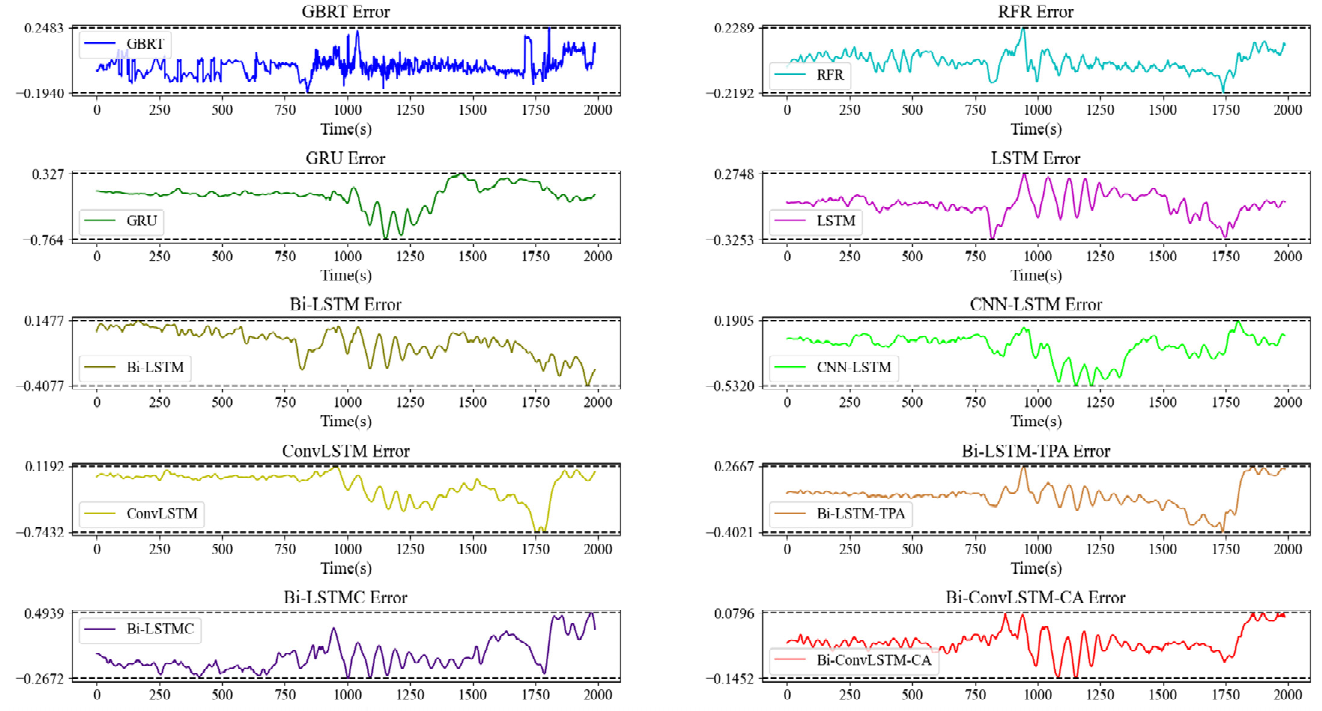
Figure 12. Ship pitch angle prediction results of 10 different models. ( a ) Ship pitch angle prediction results of 10 different models in 0–2000 s; ( b ) Ship pitch angle prediction results of 10 different models in 700–1000 s.